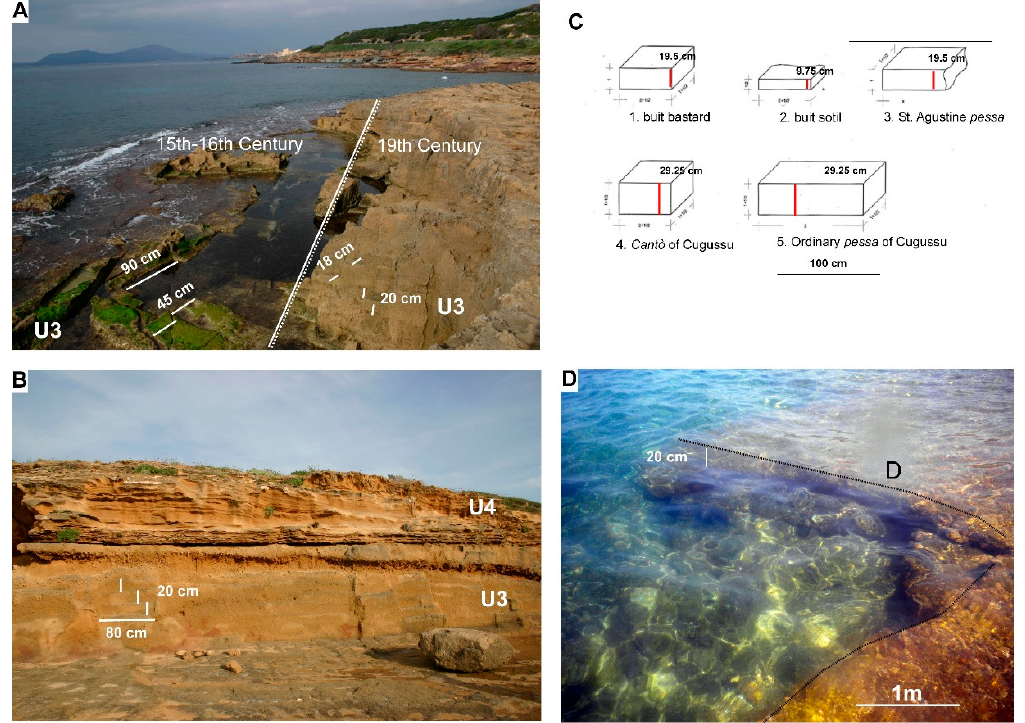
Figure 11. Cantaro quarry. A ) Sea side of the quarry. Note the different block size between the quarry floor active during 15th and 16th Centuries and the wall reactivated in the 19th Century. B ) 17th Century more inland side of the quarry. Note that the blocks’ dimensions change according to the new rate table (Tarifa de traballadors de cada office) and the introduction of the “buit” as reference dimension stone. C ) Dimension stones quarried at Alghero during the second half of 17th Century (from Tariffa de traballadores da cada Offici visible c/o the Historical Archive of Alghero, 1658, file 853/26). Forms are as follows (from [42]): 1. the buits bastarts (rough-hewn dimension stones), had to be two and half palms long, a palm and half wide and a palm thick; 2. the buits sotils (thin dimension stones), had a thickness of half palm, a length of two and half palms and a variable width, depending on the requests of the customer; 3. las pessas de St. Agustì (the pieces of St. Augustine) had a height of a palm and half, a thickness of a palm and the width depending on the request of the customer “la larghezza a gusto di chi la domanderà”; 4. los cantos de Cugusso (the dimension stones of Cuguttu) measured a palm and half in height, two and half palms in length and were about a half palm wide; 5. la pessa ordinaria de Cugusso (the ordinary pieces of Cuguttu) measured five palms in length and was identical in the other dimensions stones of Cuguttu (de altaria e amplaria com lo cantò pedra de Cugusso). D ) Submerged quarry floor with a curved part used for boat anchoring. The still visible step was most probably used to facilitate boat loading. The dock (D) is 20 cm below the present low tide sea level and about 20 cm high.